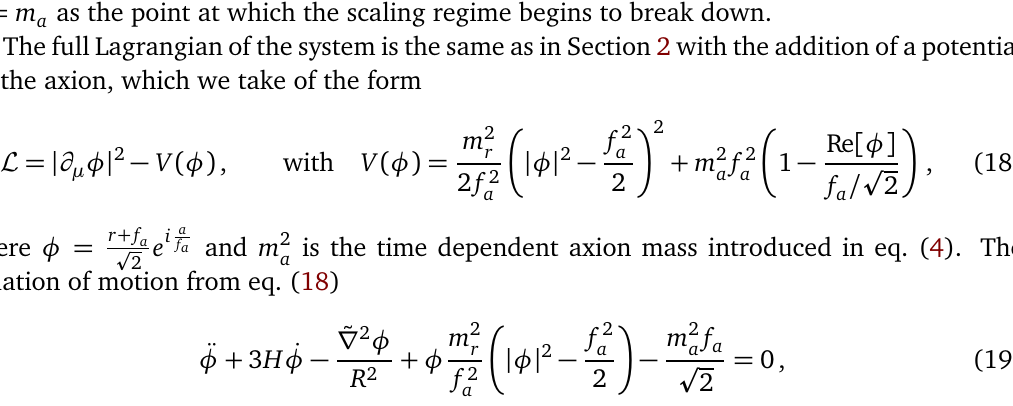
Figure 21: Left: The scaling parameter ξ as a function of time when the axion mass is turned on at different log (cid:63) ≡ log ( m (cid:63) with the same initial condition (dashed lines). The x-axis is normalized with H (cid:63) , so it can be seen that regardless of log (cid:63) , ξ is unaffected by the mass before H = H (cid:63) . Right: The relative difference between the results for ξ with and without a non-zero axion mass, δξ/ξ , as a function of time. We define δξ ≡ ( ξ − ξ is the string length in a simulation with m tested the effect of a non-vanishing axion mass is smaller than percent for H > H (cid:63) . H = m as the point at which the scaling regime begins to break a